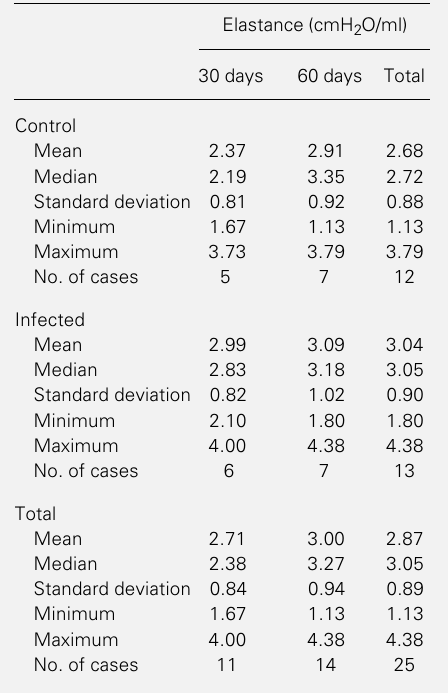
Table 2 - Paracoccidioidomycosis (PBM) infection has no effect on pulmonary elastance. Neither PBM infection (P = 0.283), time of infec- tion (P = 0.496) nor interaction infection vs time (P = 0.561) were statistically significant (ANOVA).